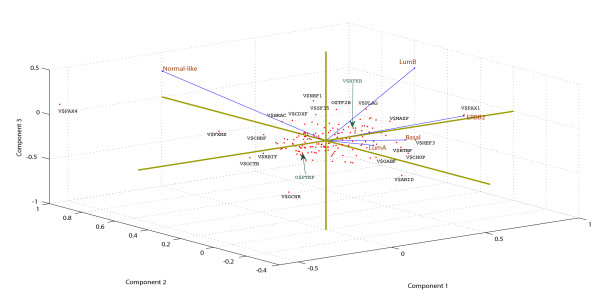
PCA plot of overrepresentated TFBS matrix families. PCA plot shown in terms of fold factor of overrepresentation in each subtype compared to the reference genomic promoters background. Blue lines represent the Eigen vectors, the direction and length of which indicates how each subtype variable contributes to the principal components in the plot. TFBS matrix families with maximum distance from the centroid are labeled on the plot.